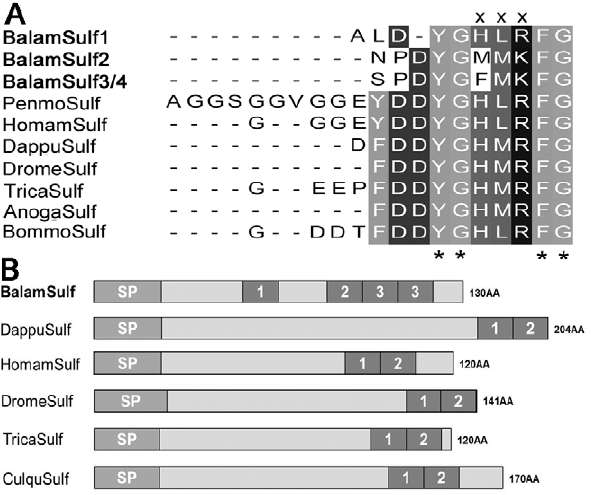
Figure 2. Comparison of barnacle sulfakinin peptide with other arthropods. (A) Sequence alignment of mature sulf. (B) Precursor structure of barnacle sulf compared with other crustaceans and insects. Insects Sulf are from: Drosophila melanogaster AAF52173, Tribolium castaneum EFA04708, Anopheles gambiae AAR03495, Bombyx mori NP_001124354 and Culex quinquefasciatus XP_001846221; branchiopod is from Daphnia pulex EFX80896; decapods Sulf are from Homarus americanus and Penaeus monodon [38]. Asterisks ‘‘*’’ represent typical motif residues of each peptide. ‘‘x’’ indicates unique amino acid residues of B. amphitrite compared to other